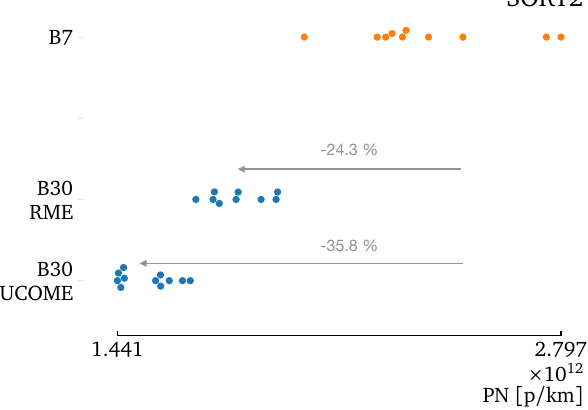
Figure 12. The easy urban SORT 2 test runs indicate lower PN emissions for B30 RME and B30 UCOME compared to B7 with an average decrease varying between 24% and